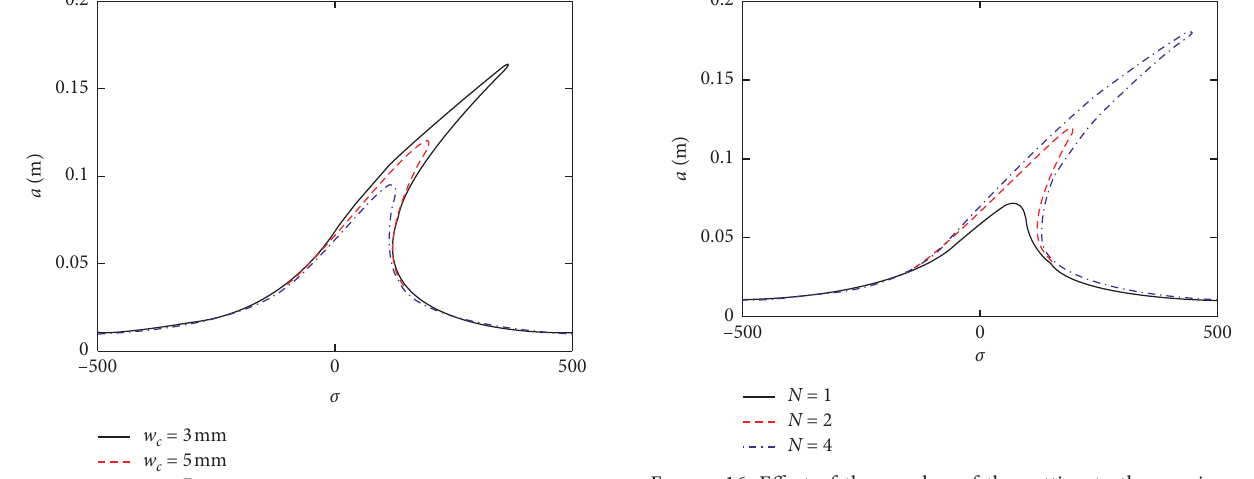
Figure 16: Effect of the number of the cutting teeth on primary resonance curves.